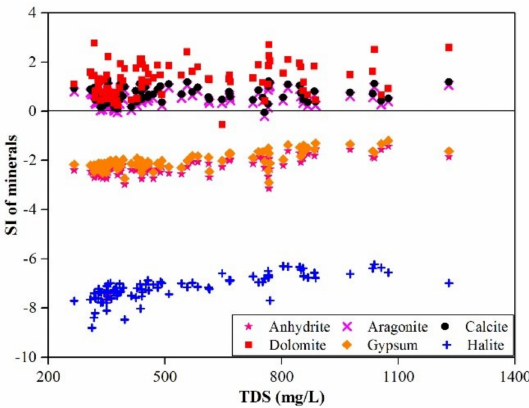
Figure 6. Relationships of saturation indices of selected minerals with total dissolved solids (TDS).